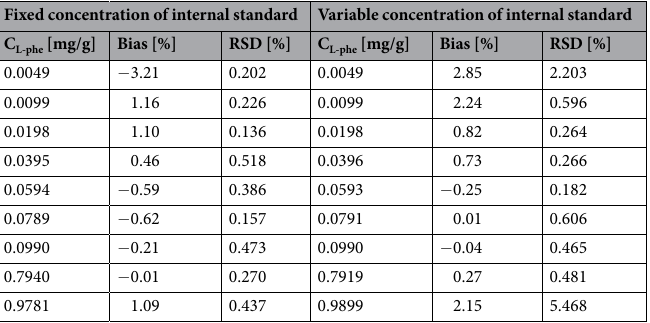
Table 2. Method performance of L-phenylalanine quantitation by circular